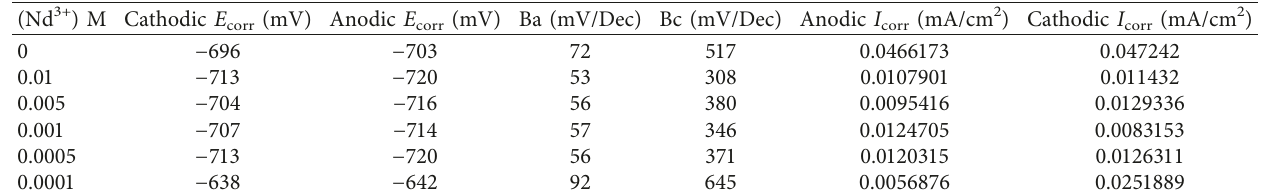
Table 1: Electrochemical parameters of the polarization curves in the presence of Nd 3+ ions.